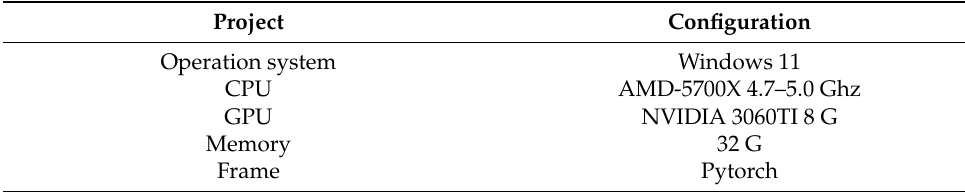
Table 1. The experimental target dataset was NSL-KDD. Table 1. Experimental platform.